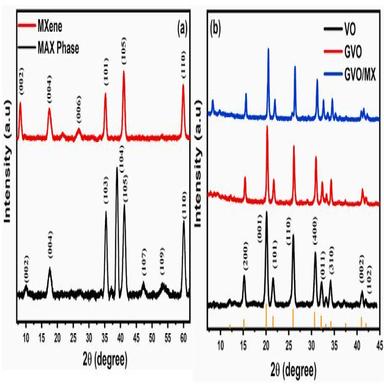
(a) XRD spectrum of MAX powder and MXene along, (b) XRD spectrum of VO, GVO and GVO/MX.